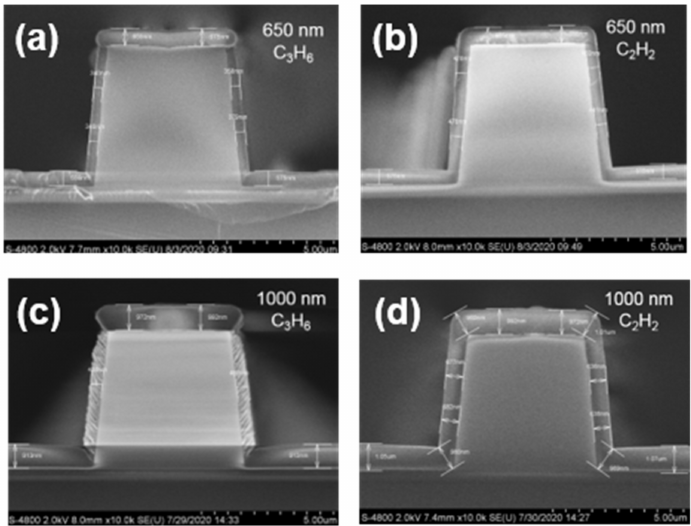
Figure 3. The SEM images showing the cross section of SC performance of different ACHM thick- nesses with C 3 H 6 and C 2 H 2 as carbon sources: 650 nm ACHM at 200 ◦ C obtained using ( a ) C 3 H 6 and ( b ) C 2 H 2 ; 1000 nm ACHM at 400 ◦ C obtained using ( c ) C 3 H 6 and ( d ) C 2 H 2 .